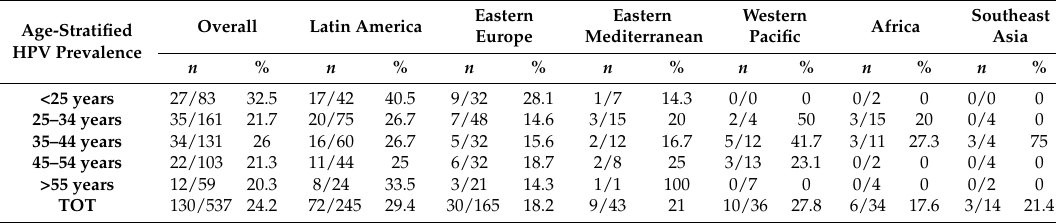
Table 2. Age-stratified Human papillomavirus (HPV) prevalence of 537 women enrolled: overall and by geographical WHO Region. Southeast Latin Eastern Eastern Western Africa Overall Age-Stratified Asia America Europe Mediterranean Pacific Age-Stratified HPV Prevalence HPV Prevalence